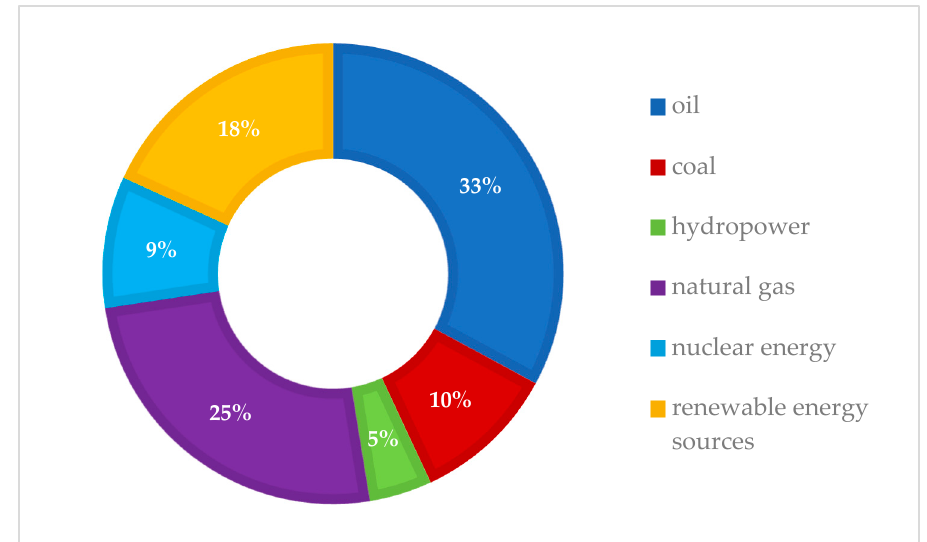
Figure 10. Forecast of energy balance in 2028 (Europe). Source: [55].